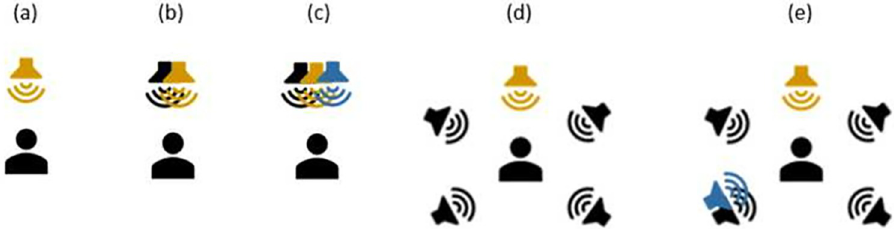
Fig 1. Speech test setups for (a) speech or music testing in quiet (S0 or M0), (b) speech in noise S0N0, (c) speech in noise S0N0T0, (d) speech in noise S0N ± 45N ± 135, and (e) speech in noise S0N ± 45N ± 135T135 (note: transient noise presented ipsilaterally to ear with the CI). Orange speaker icons indicate target signal (speech or music), black speaker icons indicate stationary noise, and the blue speaker icons indicate transient